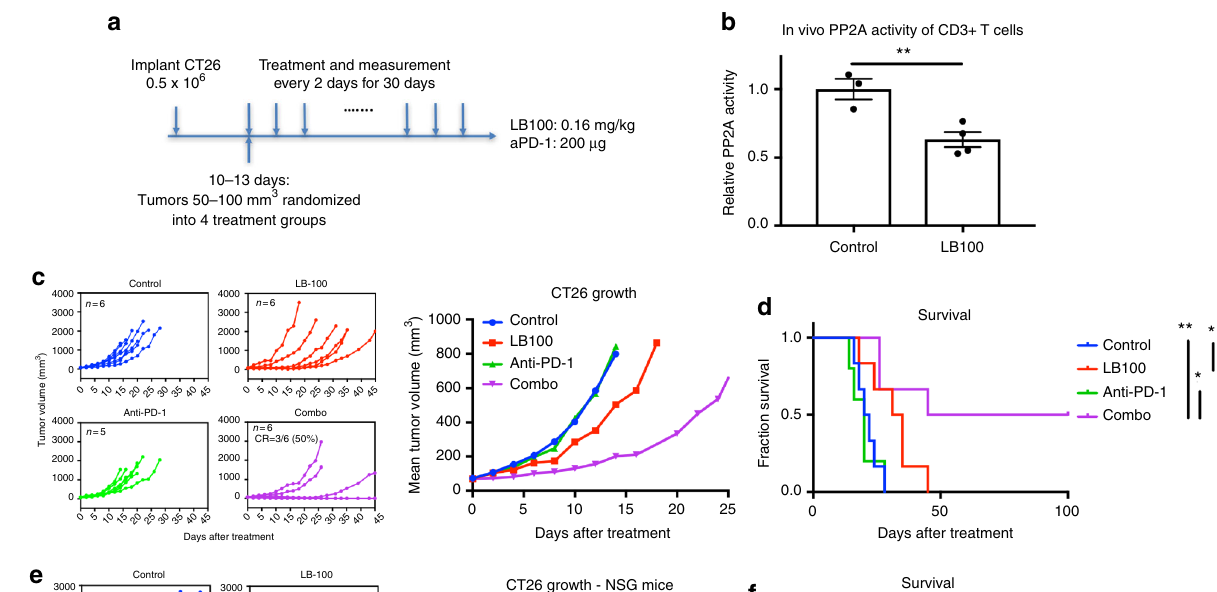
| DOI: 10.1038/s41467-018-04425-z | www.nature.com/naturecommunications